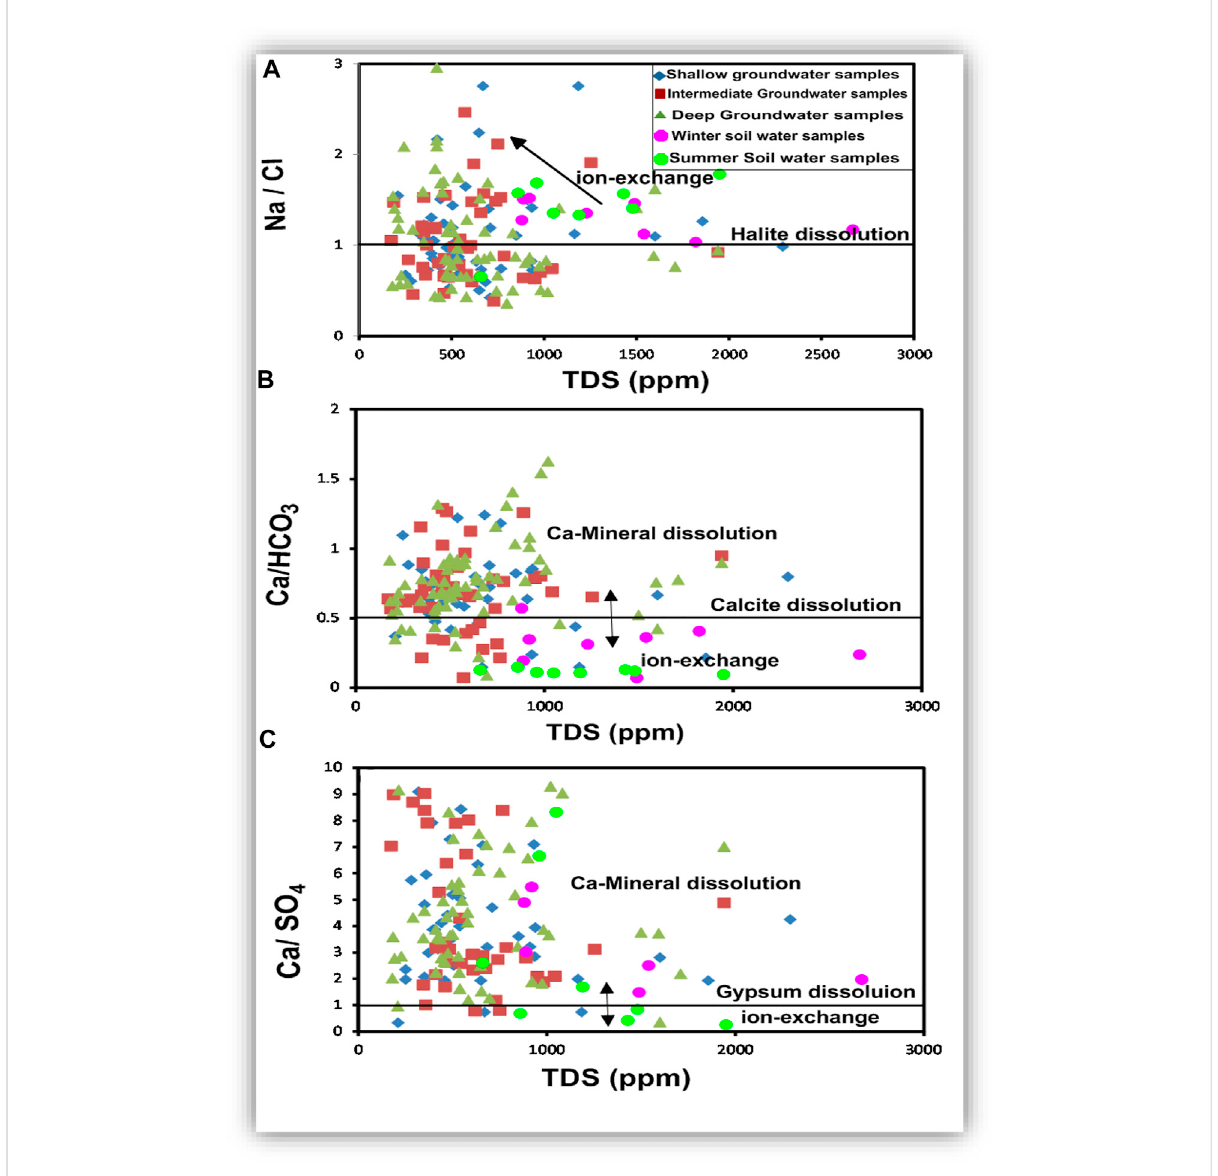
FIGURE 21 The TDS-ionic ratio relationships to estimate the effect of ion exchange and mineral dissolution on the hydrochemical composition of the